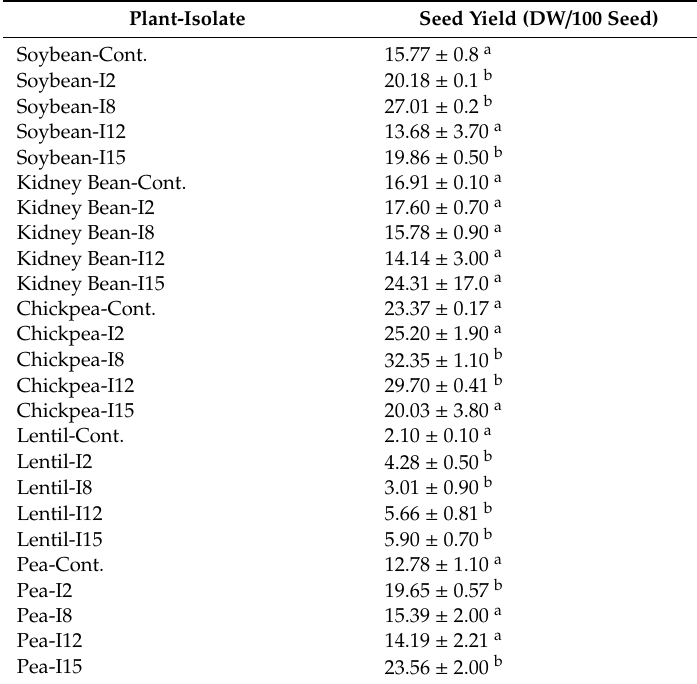
Table 4. Seed yield measured as dry weight per 100 seed of soybean, kidney bean, chickpea, lentil, and pea under control (cont.) and after enrichment with biologically active actinomycete isolates. Values are the average of three individual replicates (means ± S.D). Di ff erent letters represent significant di ff erences between the treatments in each crop (Duncan test; p < 0.05; n =